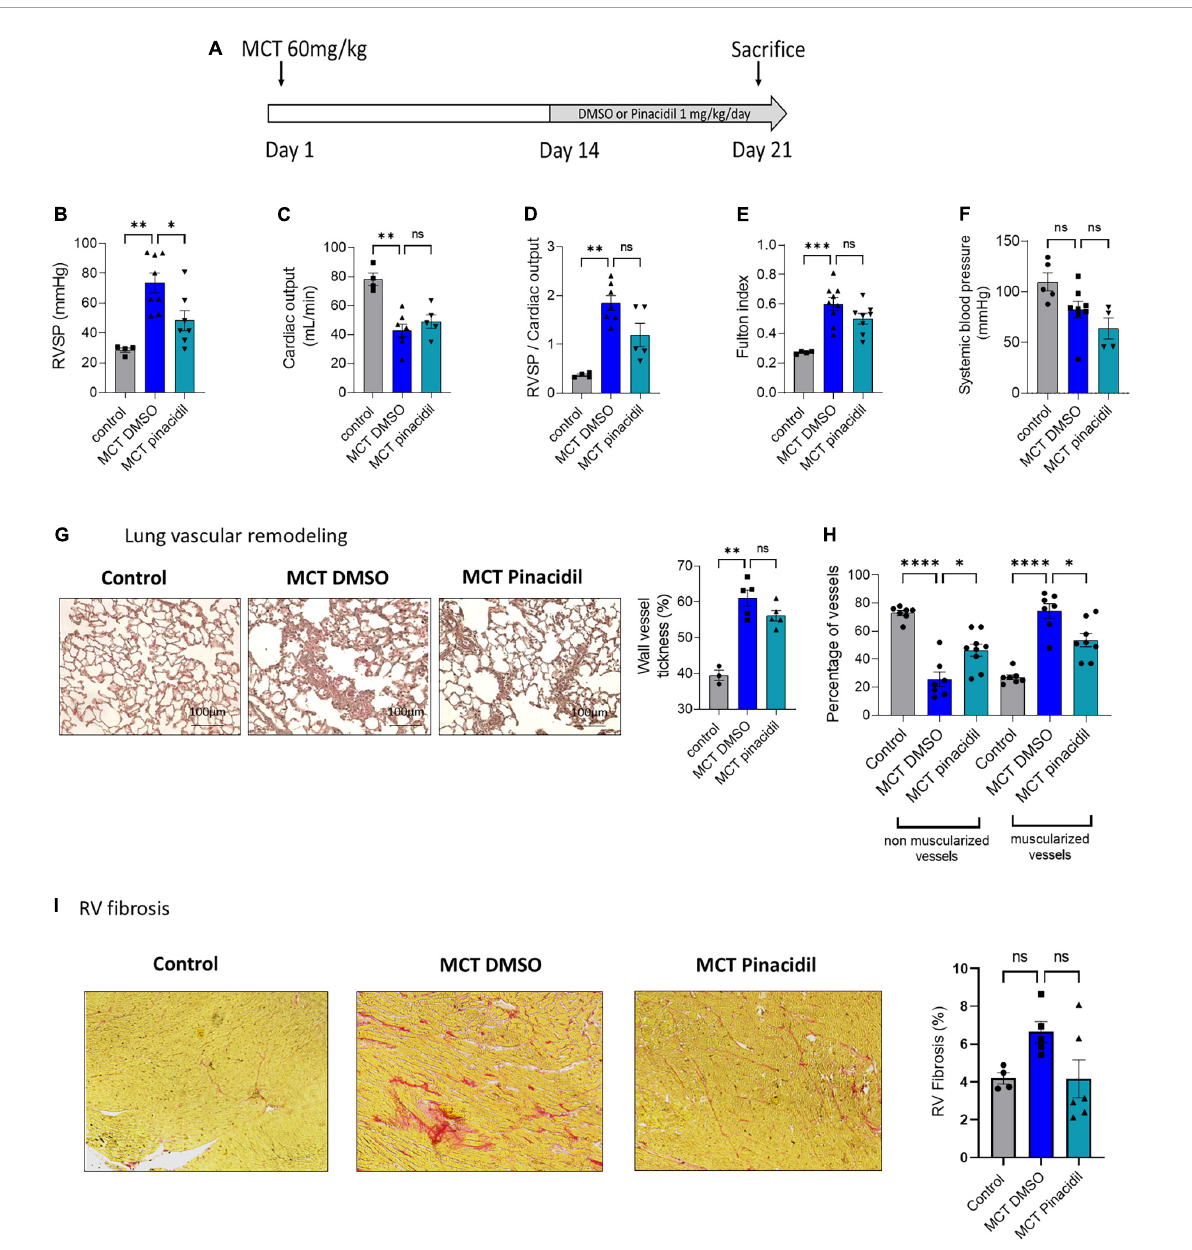
FIGURE7 In vivo curative pinacidil treatment reduces the development of PH in MCT-PH rats. (A) In vivo experimental design. Pinacidil (1 mg/kg/day from day 14 to day 21) was administered short-term during MCT exposure by intraperitoneal injection. (B) RVSP (mm Hg; n = 4–8 different rats per condition) (C) , Cardiac output (CO; ml/min) ( n = 4–7 different rats per condition). (D) PVR (evaluated by the RVSP/CO ratio) ( n = 4–7 different rats per condition). (E) Fulton index (RV/LV + septum) ( n = 4–8 different rats per condition). (F) Pulmonary vessel occlusion (%) was analyzed by HES ( n = 3–5 rats per condition). (G) Percentage of non-muscularised and muscularised vessels [100 vessels per rat, ( n = 6–8 rats)] as measured by immunostaining against α SMA and VWF. (H) Interstitial fibrosis was identified with Sirius red staining in the RV compartment from control, MCT + DMSO, and MCT + pinacidil rats. (I) Quantification of the percentage of fibrosis in RV tissue in each condition ( n = 20 images per rat from 4–5 different rats). ns: non-significant, ∗ P < 0.05, ∗∗ P < 0.01, ∗∗∗ P < 0.001, ∗∗∗∗ P <